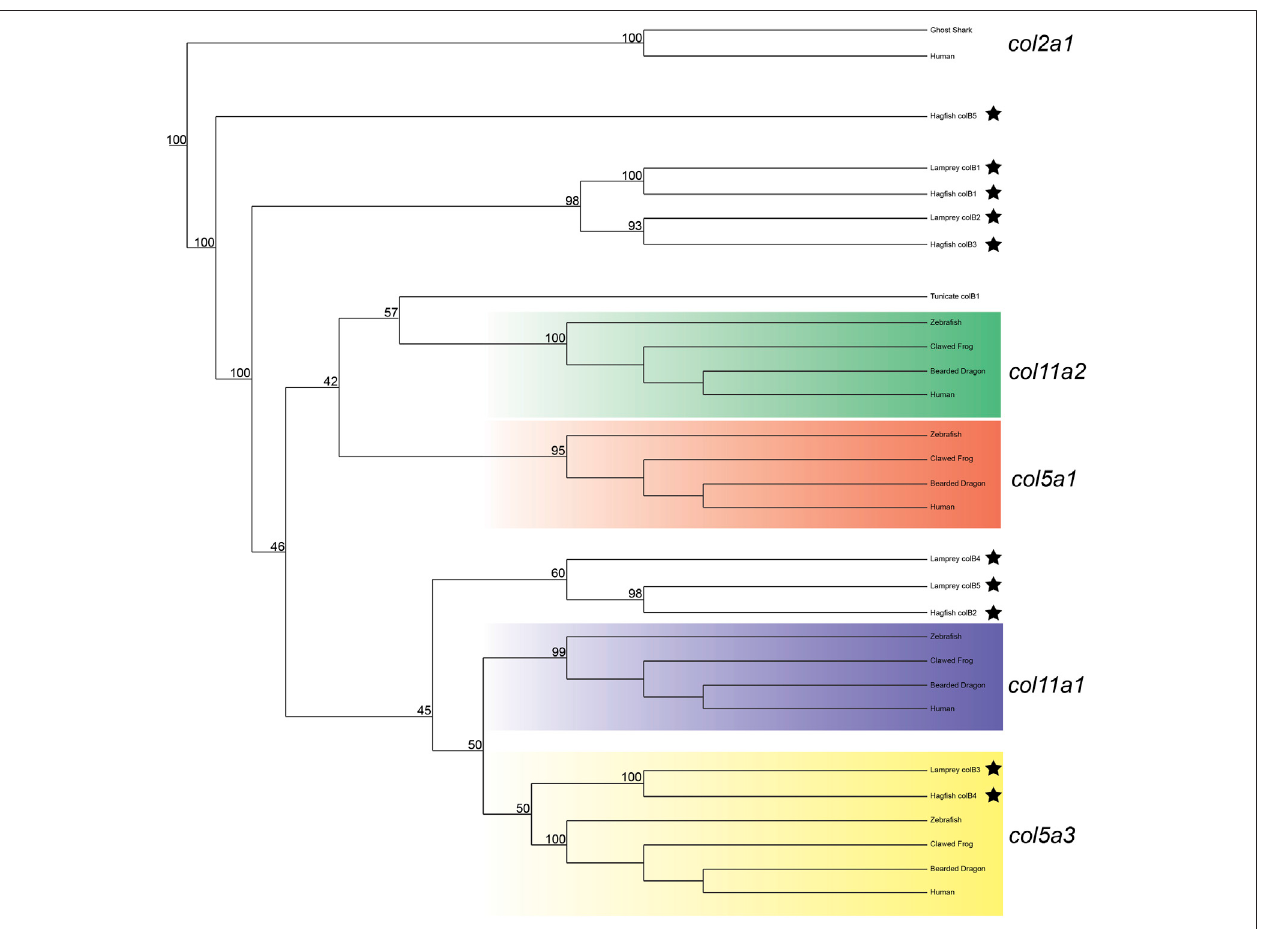
FIGURE 3 | Recreated phylogenetic tree built from vertebrate and tunicate Clade B fi brillar collagen sequences. Maximum likelihood analysis scores are shown at therespectivenode.Thehumanandghostshark col2a1 geneswerechosenasthemostrelevantoutgroup.Cyclostomegenesarelabelledwithablackstar.Originaltree can be found in Supplementary Figure S5 . Accession numbers for all sequences can be found in Supplementary Table S6 .